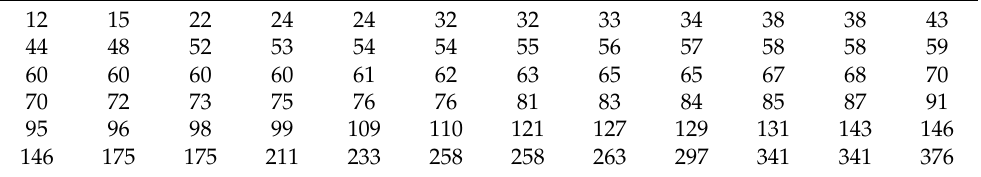
Table 7. Data set of survival times of guinea pigs.